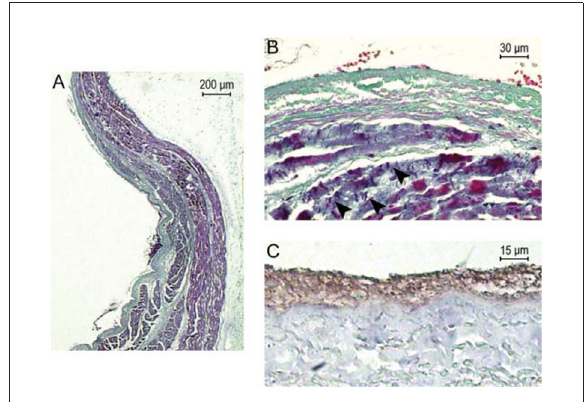
FIGURE1 Reproduced with permission from Pérez-Castellano et al. (16). Acute pathological effects of PV β -radiation. This pig was euthanized just after radiation. (A) Longitudinal section of the right PV at the level of the radiated area (Masson’s trichrome stain). At the luminal side of the vein (left), a laminar fibrin thrombus is adhered to the intima along a large area of endothelial denudation. A thick PV sleeve (purple) can be appreciated under the PV adventitia, which gets thinner as it enters the vein. There is some collagenous connective tissue among PV sleeve fascicles. (B) Previous preparation at higher magnification where PV sleeve myocardiocytes can be observed displaying marked fuchsinophilia and contraction bands (arrowheads), which are signs of impending necrosis. The absence of nuclei at the intima suggests endothelial denudation. At the lumen, there are several red blood cells included in fibrin. (C) CD-31 stain to best appreciate the absence of endothelial cells between the fibrin thrombus (brown) and the vein wall